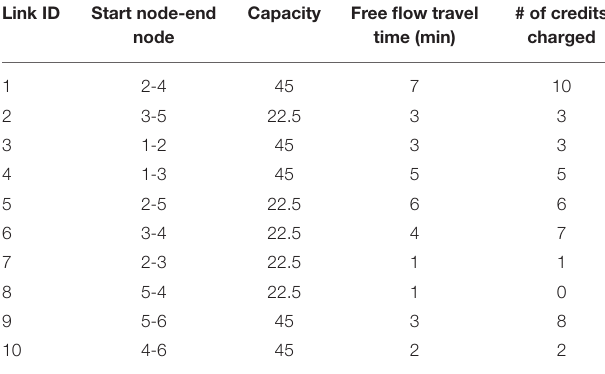
TABLE 1 | Link parameters for the six-node network.